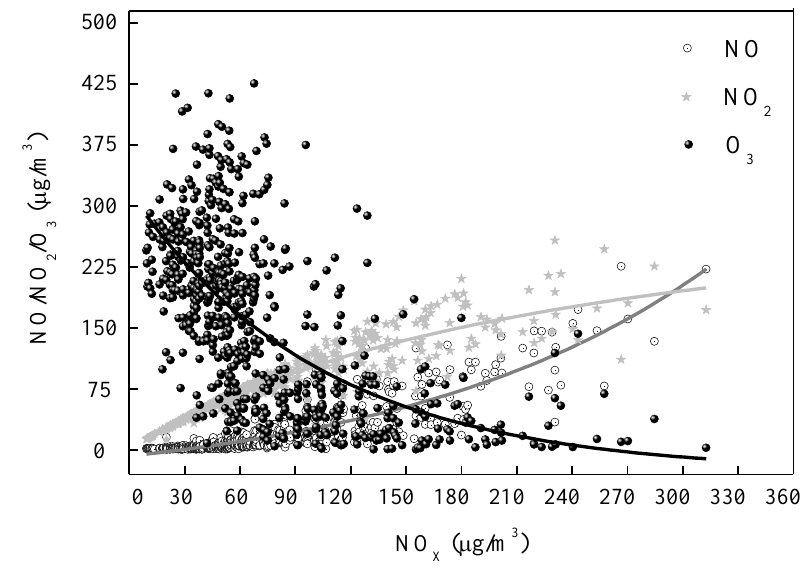
Figure 5. Variations of daylight average concentrations of O level of NO X